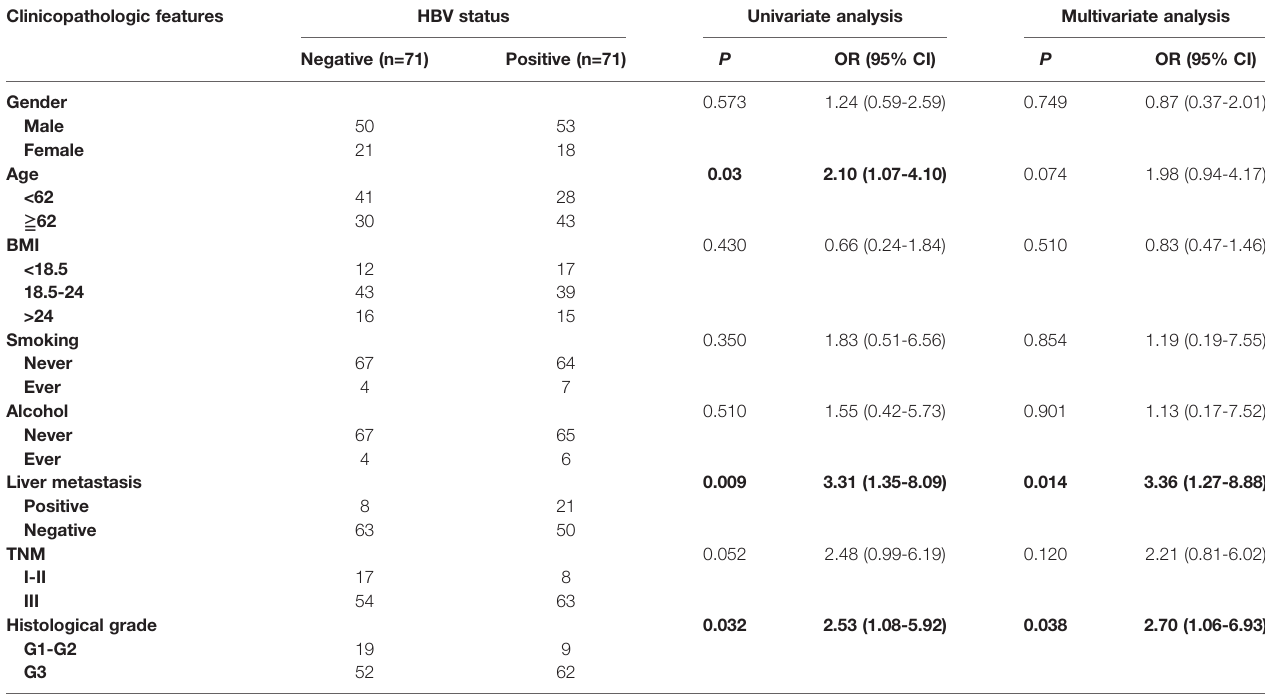
TABLE 2 | Univariate and multivariate logistic regression analyses for the associations between serum HBV positive and HBV negative postoperative gastric cancers. Clinicopathologic